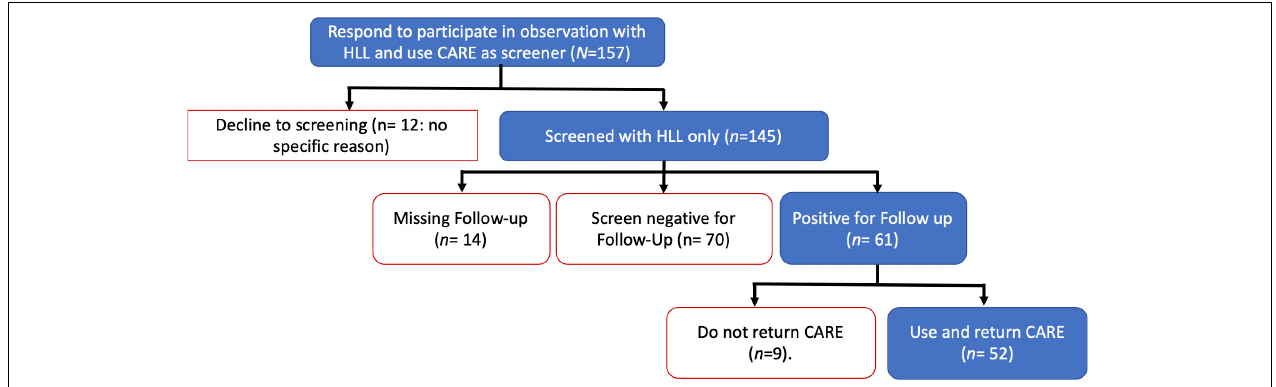
FIGURE 1 | Consort diagram for participants called for screened with the Haizea-Llevant screening table and to use CARE at home. HLL, Haizea-Llevant; CARE, The Compilation of Activities to Report and Enhance development booklet. One-month pass between the positive Follow-up and the caregivers return of CARE booklet used as screening